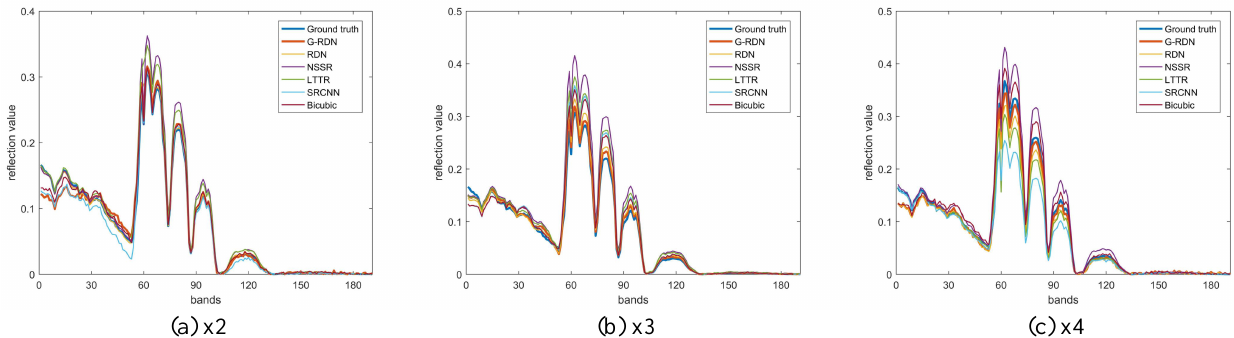
(a) Figure 15. Visual exhibition of the reconstructed Washington DC Mall at the scaling factor of 4.